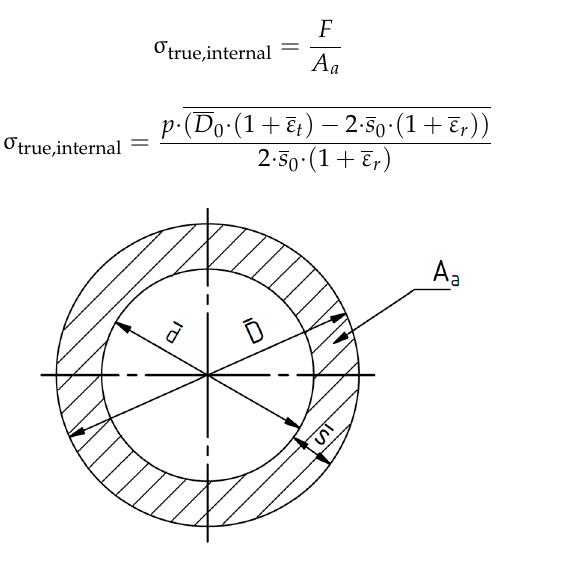
Figure 8. Geometric variables to calculate the effective cross-sectional area of the tube specimens.